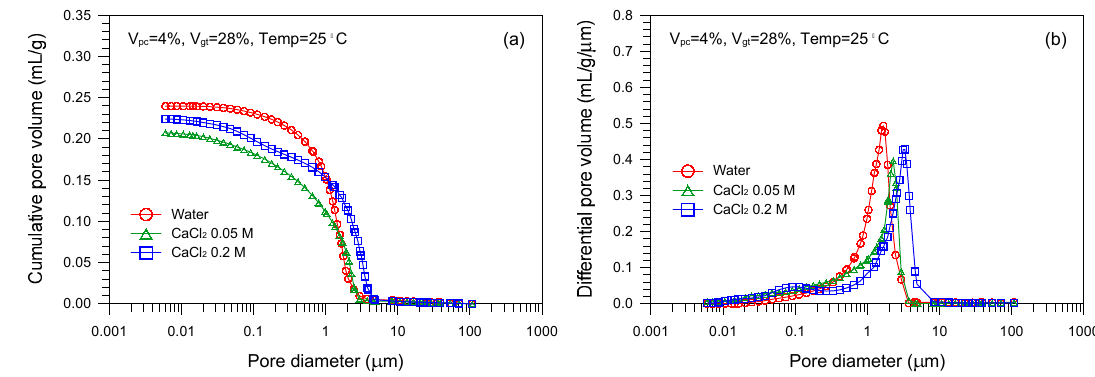
Figure 5. Effect of curing temperature on pore size distribution of cement-stabilized tailings: ( a ) cumulative intrusion curve, ( b ) differential instruction curve.